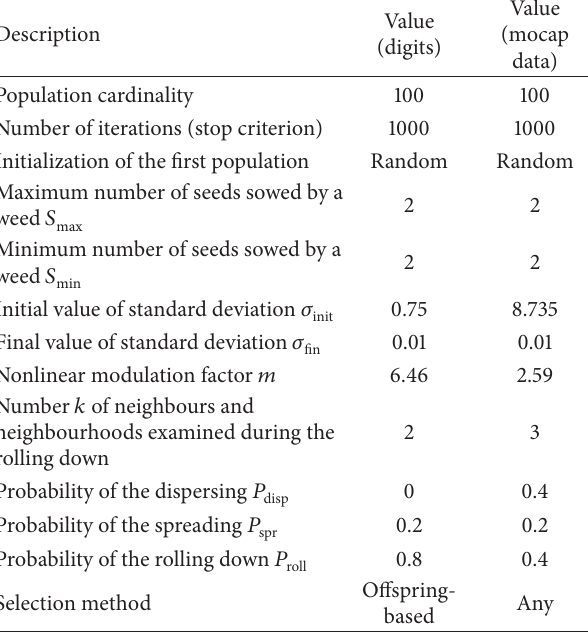
Table 5: The parameters of exIWO used for feature selection.